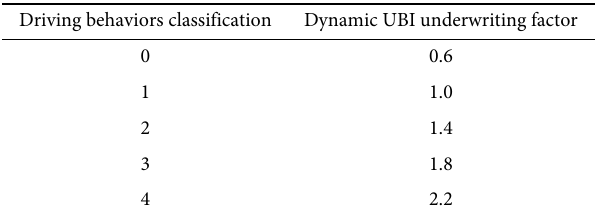
Table 2 Driving behavior category corresponding to the dynamic UBI underwriting factor.